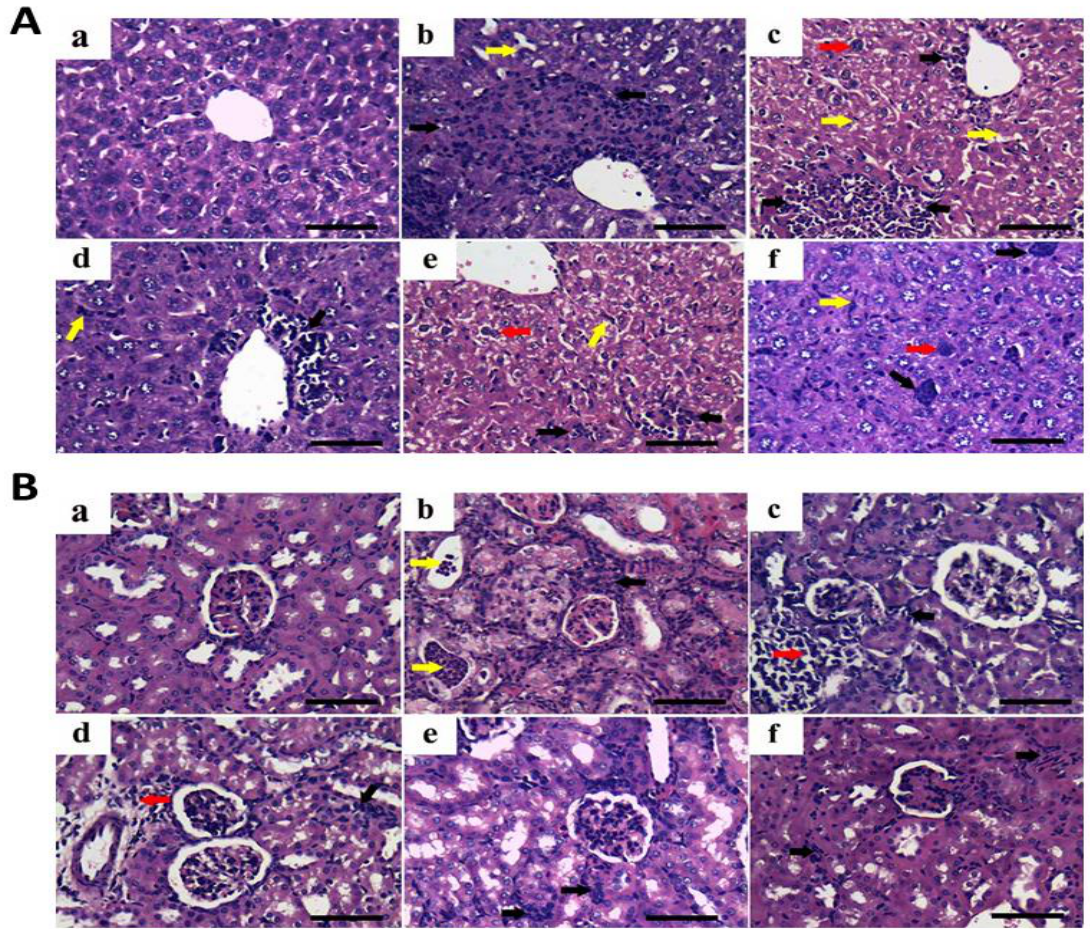
Figure 10. Representative photomicrographs for H&E-stained liver ( A ) and kidney ( B ) tissues (bar = 50 µ m) of ( a ) positive control group, ( b ) free HK, ( c ) free RST, ( d ) free PMT, ( e ) free (HK/RST/PMT) combination therapy and ( f ) crosslinked HK-loaded PMT–ALG/LF–RST NHs F10 treated groups. Liver: black arrows: pleomorphic, hyperchromatic, metastatic tumor foci; red arrows: chromatin condensation or abnormal mitotic figures; yellow arrows: invasion of sinusoids with tumor and Kupffer cells. Kidney: black arrows: periglomerular and interlobular infiltration; red arrows: perivascular infiltration; yellow arrows: intratubular